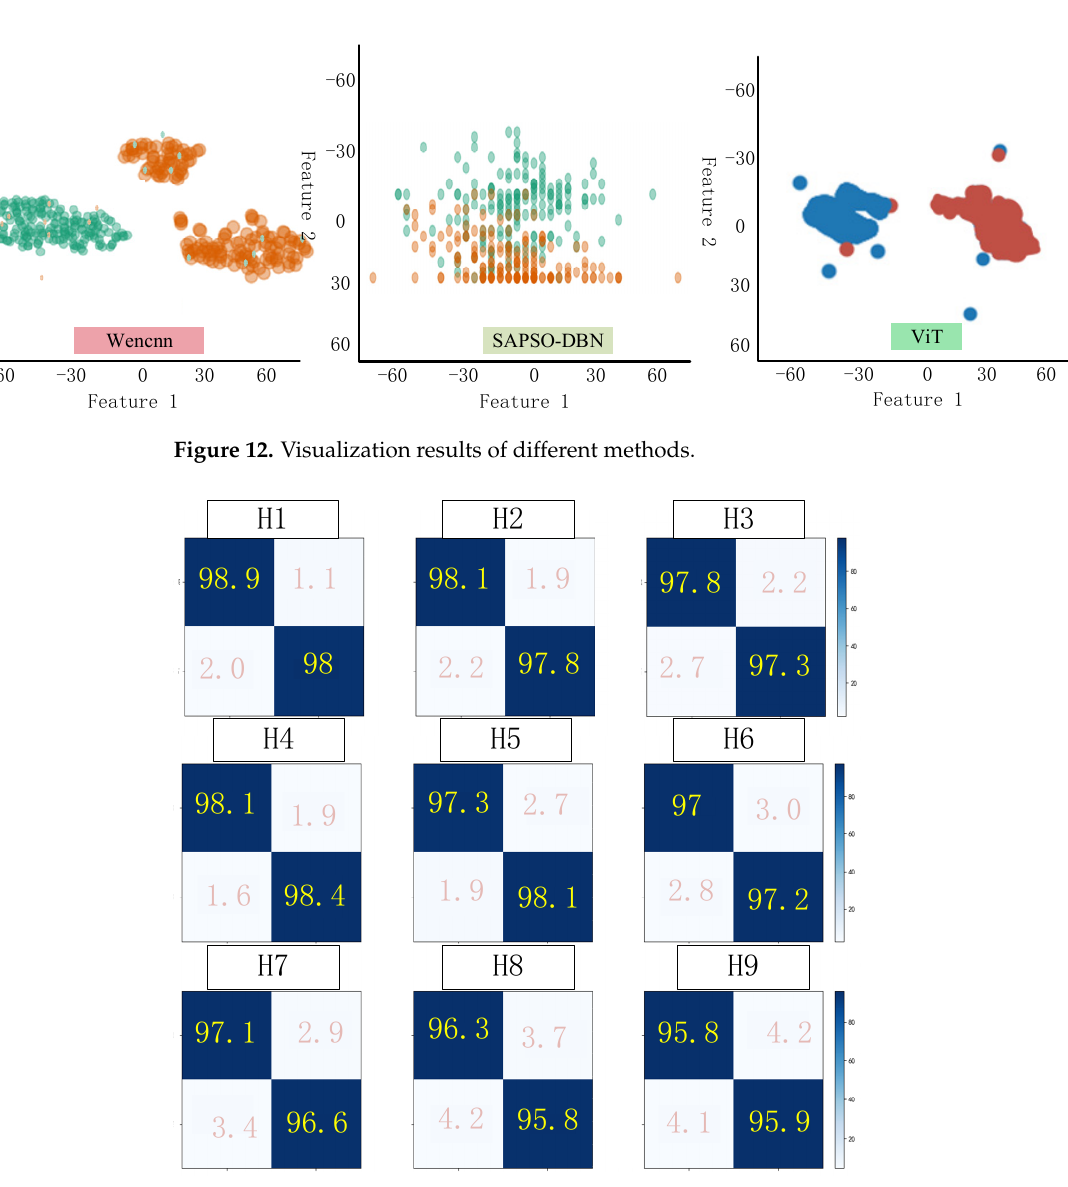
Figure 13. Confusion matrix of nine working conditions of coal gangue identification.